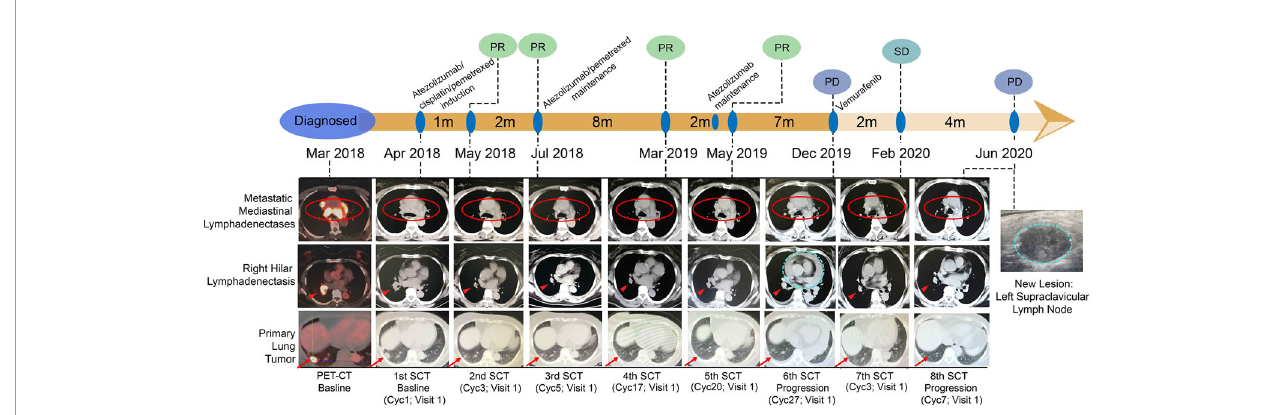
FIGURE 2 | Course of the disease, treatment history, and response evaluation. 1st surveillance CT (SCT): baseline, atezolizumab/cisplatin/pemetrexed induction (Cyc1, 2018/04/11);2nd SCT: post-induction two cycles (Cyc3, 2018/05/28),PR;3rd SCT: post-induction four cycles, atezolizumab/pemetrexedmaintenance (Cyc5, 2018/ 07/12),PR; 4th SCT: post-atezolizumab/pemetrexed maintenance 12 cycles (Cyc17, 2019/03/25),PR; 5th SCT: post-atezolizumab maintenance one cycle(Cyc20, 2019/ 05/27),PR. NOTE: Atezolizumabmaintenance on C19V1. Tumor assessment every9 weeks(three cycles) after the completion ofthe week 48 tumor assessment per protocol (Cyc20, 2019/05/27); 6th SCT: post-atezolizumab maintenance eight cycles (Cyc27, 2019/12/17), PD;7th SCT: post-Vemurafenib two cycles (Cyc3, 2020/02/03), SD;8th SCT: post-Vemurafenib six cycles (Cyc7, 2020/06/04), PD. Red circles: metastaticmediastinal lymphadenectases; Red short arrows: right hilar lymphadenectasis; Red long arrows: primarylungtumor;Blue dotted cycle: new lesion;lesion 1: pericardial effusion (progression onICPi); lesion 2: leftsupraclavicular lymph node(progression on BRAFi).PR,partial response; SD, stabledisease; PD,progressivedisease; ICPi, immune check-point inhibitor; BRAFi, BRAF inhibitor.